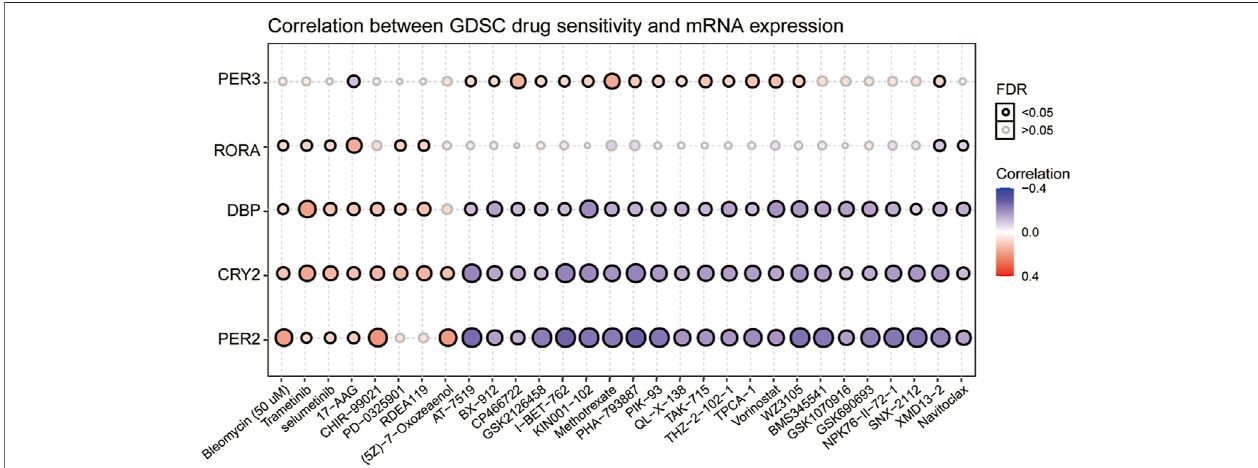
FIGURE 10 | Correlation between GDSC drug sensitivity and six prognostic core clock genes. The correlation between rhythm genes and drug sensitivity in pan- RCCwasstudiedbySpearmancorrelationanalysis.Here,columnsrepresentGDSCdrugsensitivityandrowsrepresentclockgenes,redrepresentspositivecorrelation between GDSC drugs sensitivity and rhythm genes mRNA expression, and blue represents negative correlation between GDSC drugs sensitivity and rhythm genes mRNA